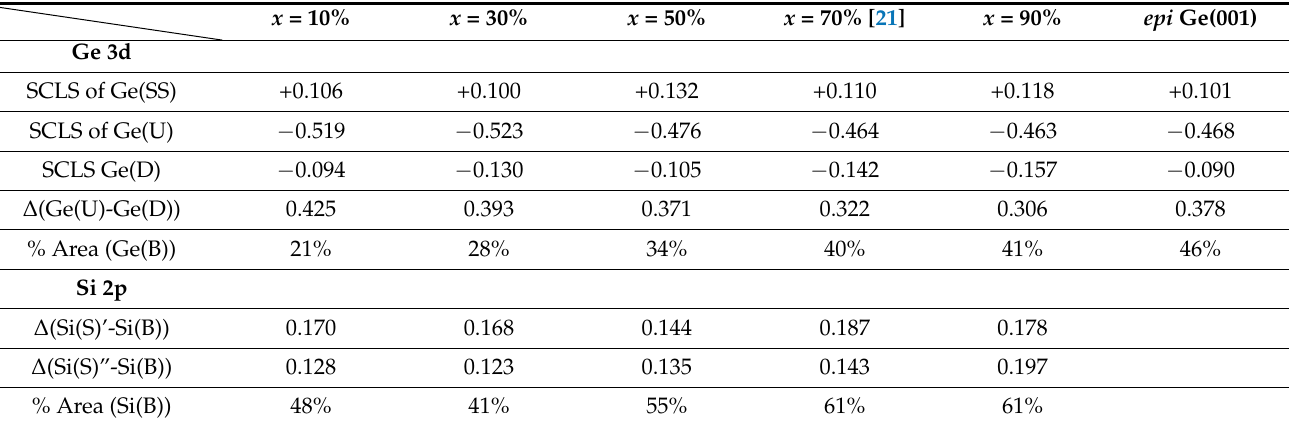
Table 2. Fitted parameters of the Ge 3d and Si 2p core-level spectra in Figures 5 and 6. SCLS stands for the surface core-level